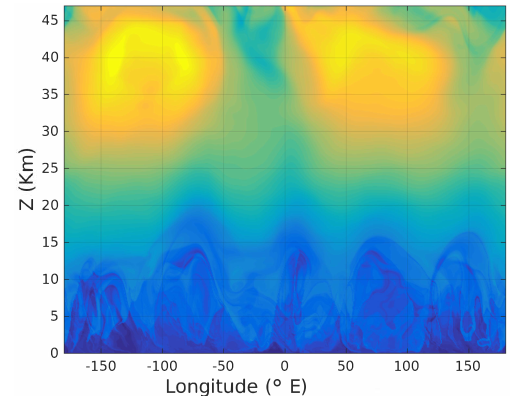
Figure 7. 15 August 1979 00:00:00UTC. M for τ = 5 days dis- played along the vertical slice passing through latitude 60 ◦